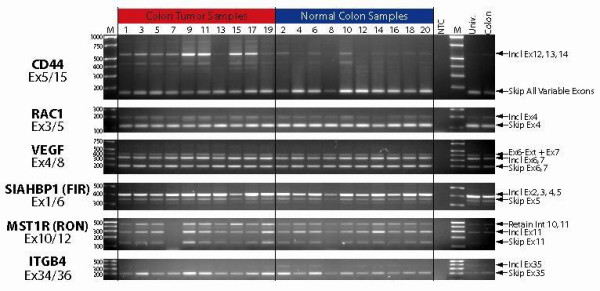
PCR validation of previously reported colon cancer-specific splicing events. See Fig. 6 for description.